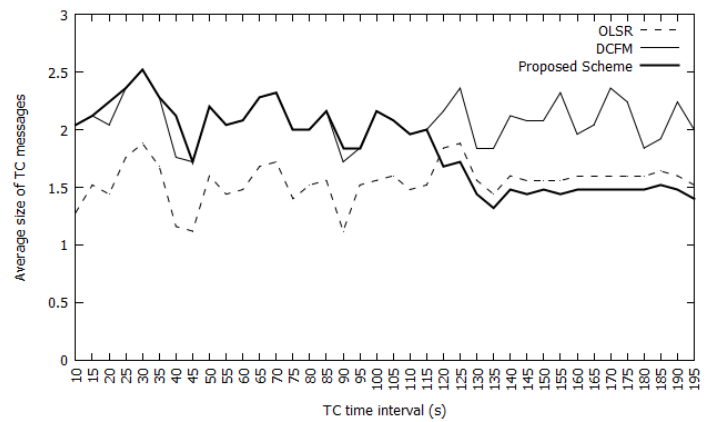
Figure 12. Comparison of Average Overheads (average TC message